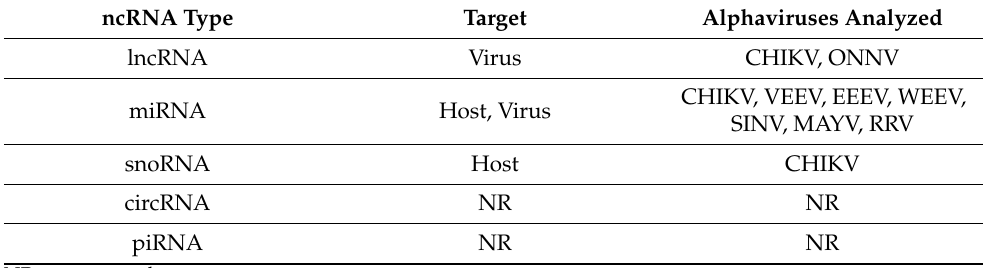
Table 1. ncRNAs in alphavirus